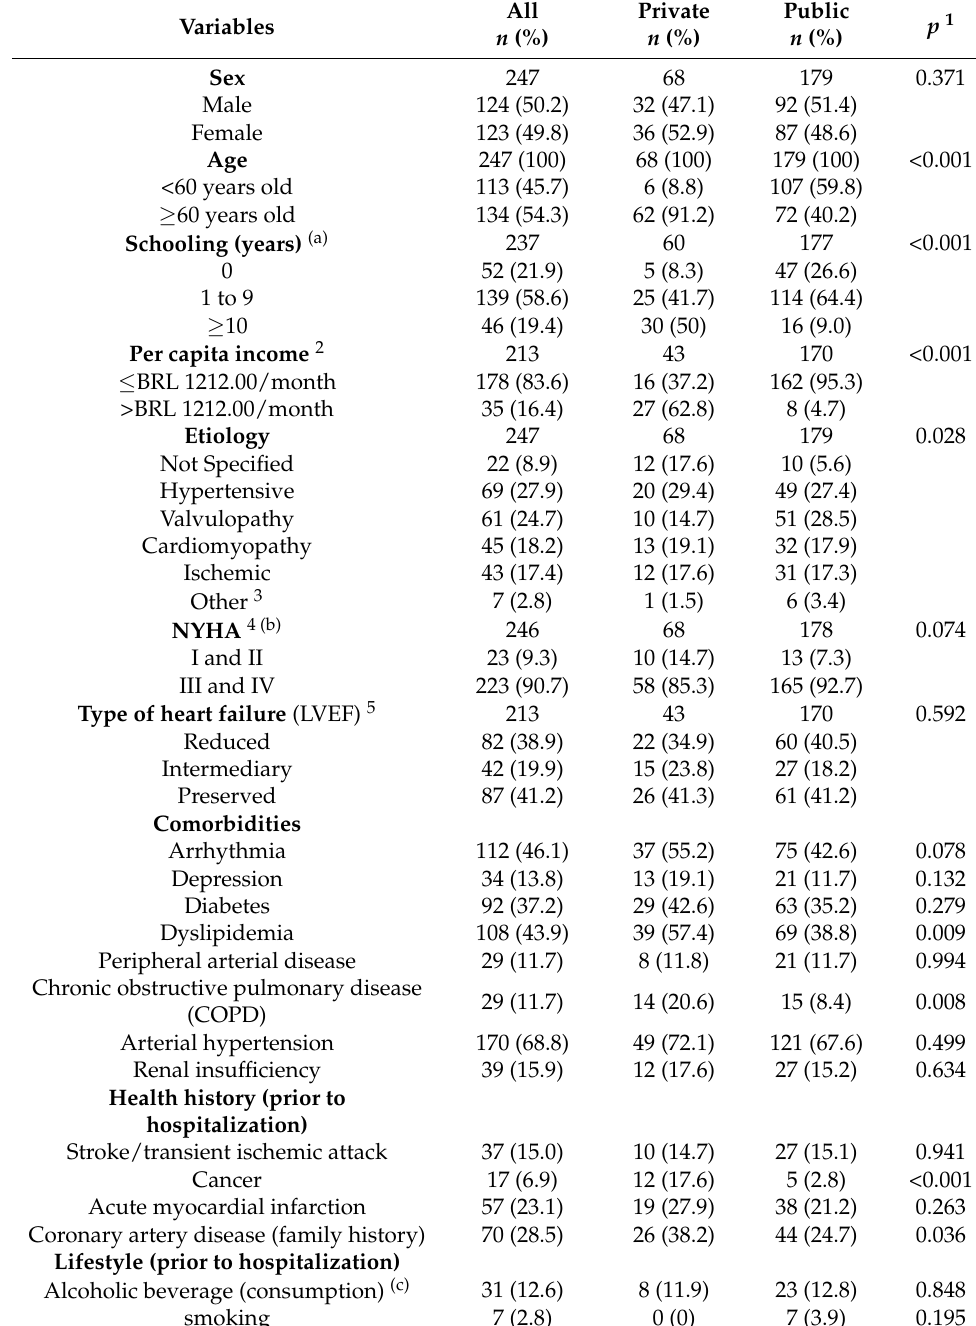
Table 1. Socioeconomic and health history characterization of hospitalized patients with heart failure, in the public and private health systems of Brazil, from April 2018 to January 2021.